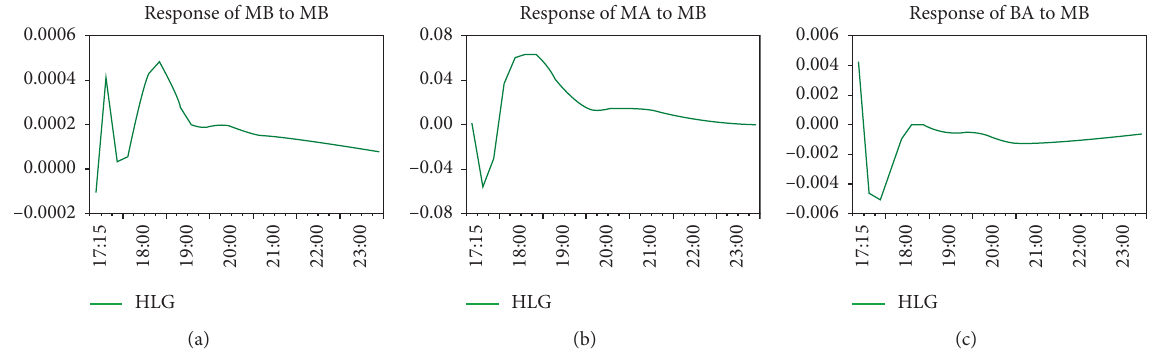
Figure 7: Response to the change in ZGC metro boarding volume at 17: 00. (a) Response of MB to MB. (b) Response of MA to MB. (c) Response of BA to